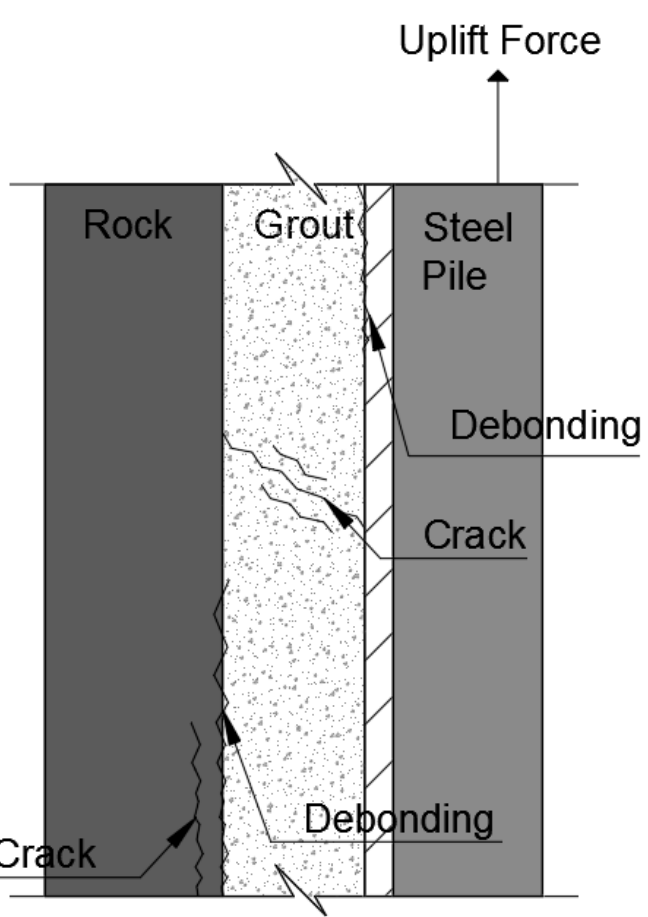
Figure 4. Pull-out fracture modeling of pre-bored piles. Since the uniaxial compressive strength of most rocks is generally higher than the uniaxial compressive strength of the grout, shear failure usually occurs in the pile-filling material before the shear failure of the rock and the skin friction of the pile embedded in the rock is determined by the adhesion strength between the pile and the pile-filling material. Moon et al. [12] studied the effect of the W/C (water/cement, hereinafter called W/C) ratio of the pile-filling material and the fine aggregate mixing ratio on the uniaxial compressive strength, and the uniaxial compressive strength of the pile-filling material was about 7–36 MPa depending on the mixing ratio. Moon et al. [11] measured the load and displacement at the pile head after injecting grout with a W/C ratio of 50% into basalt perforated with a diameter of BX (BX is a casing standard of out diameter of 59.0 mm used for standard penetration tests) and inserted a structural steel pipe (outer diameter of 48.6 mm). The skin friction of the steel pipe pile embedded in the bedrock was determined by the adhesion strength of the steel pipe and the grout, and the unit ultimate skin friction was in the range of 0.92 to 1.04 MPa. In a study by Moon and Park [13], in the absence of fine aggregate, the unit ultimate skin friction was 0.54 to 0.56 MPa regardless of W/C. Table 4 shows our field conditions (D = 0.6 m in diameter and 1.92 m in rock penetration condition) using the unit ultimate skin friction values determined in a previous study by Moon et al. [11] and Moon and Park [13]. As shown in Table 4, this is the result of calculating the allowable skin friction. The allowable skin friction was about 651.1 to 1109.29